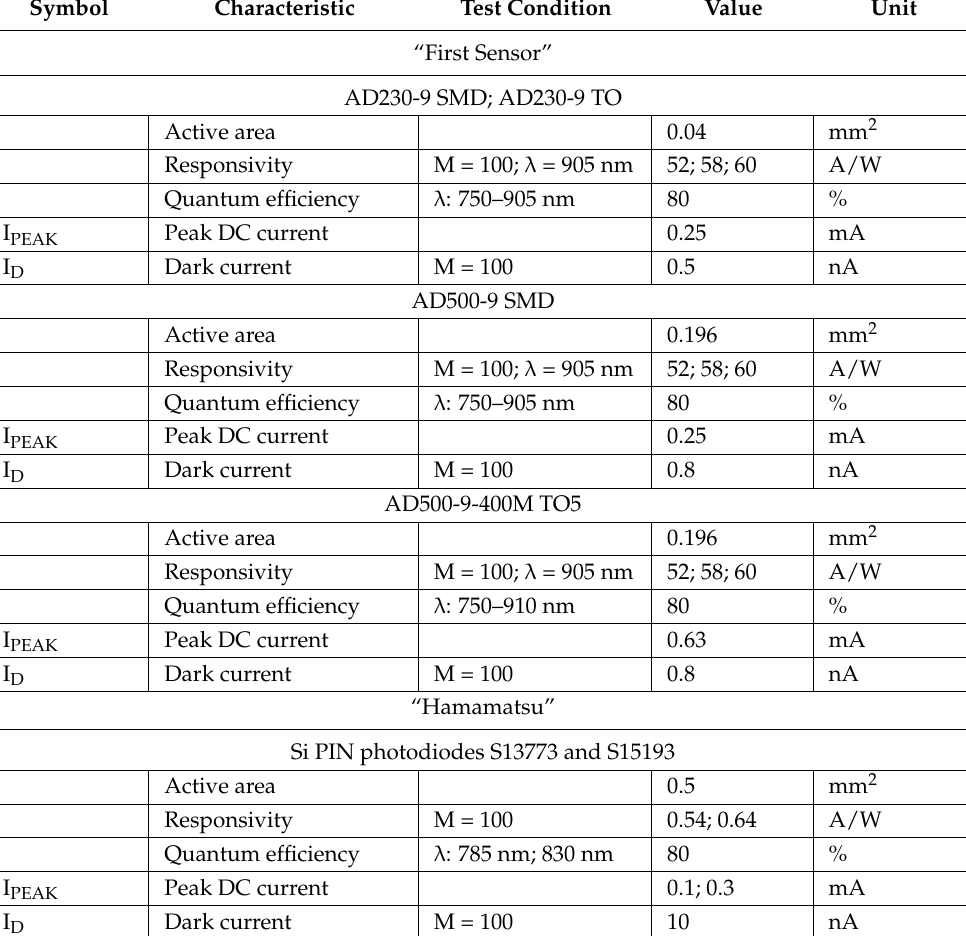
Table 1. Main electro-optical characteristics, t = 23 ◦